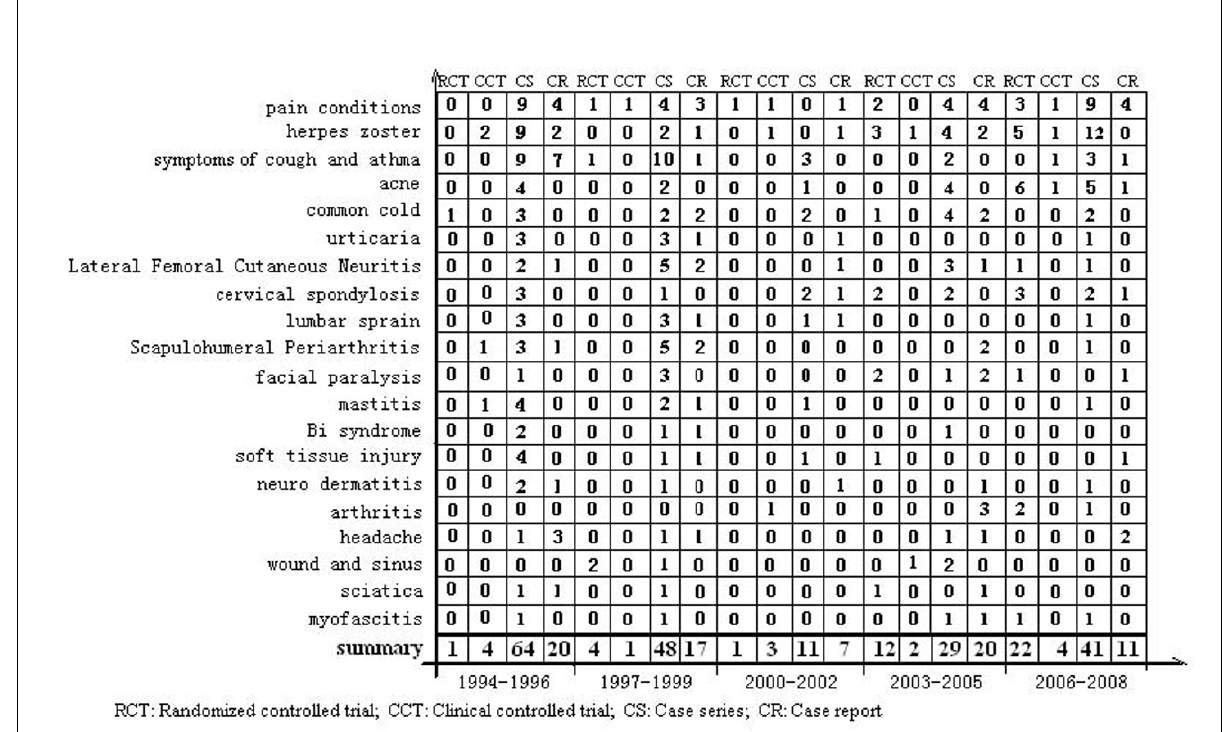
Figure 5 Mapping of top 20 diseases by study type between 1994 and 2008.